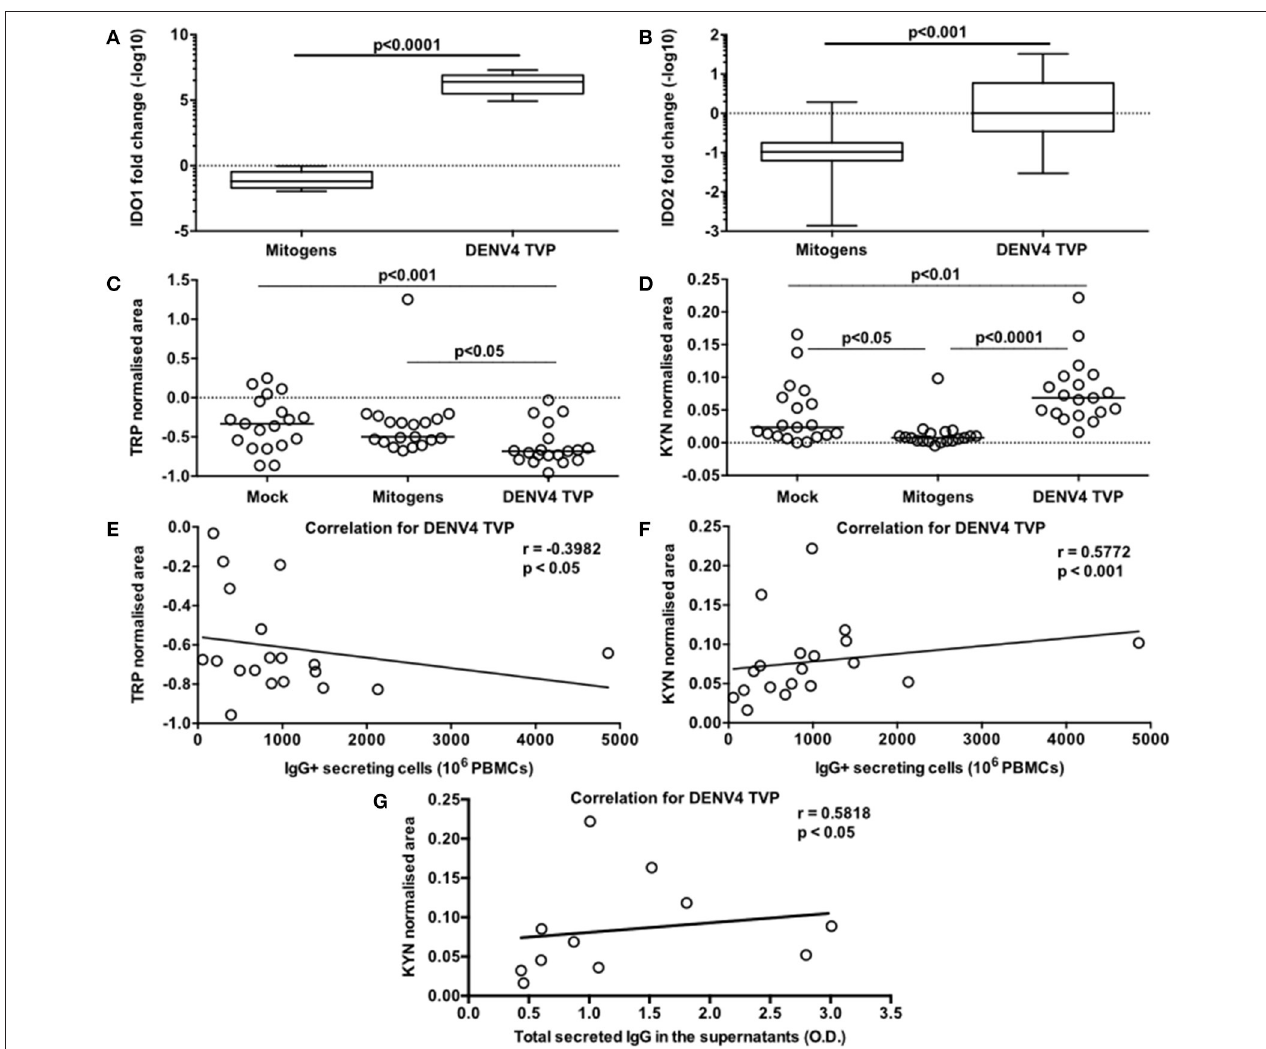
FIGURE 5 | Activation of the tryptophan metabolism is strongly associated with the DENV-mediated ASC differentiation detected in PBMCs in vitro . Different PBMC cultures derived from 19 healthy donors had their cells and supernatants harvested at day 7 of the culture. To verify the participation of the tryptophan metabolism in this cellular process, the following parameters were measured: (A,B) gene expression levels of IDO1 and IDO2 respectively in the cells; (C) Tryptophan (Trp) consumption and (D) Kynurenine (Kyn) accumulation in the supernatants; (E) correlation between the Trp consumption and ASC numbers (counted through ELISPOT); correlations between the Kyn accumulation and ASC numbers (F) or the total amount of secreted IgG in the supernatants (G) . (A,B) Data are represented as boxes and whiskers (10–90% percentile). Dashed line represents the gene expression within the Mock culture condition. (C,D) Dashed lines represent the standard amount of the metabolite found in the culture medium kept under the same conditions, but without